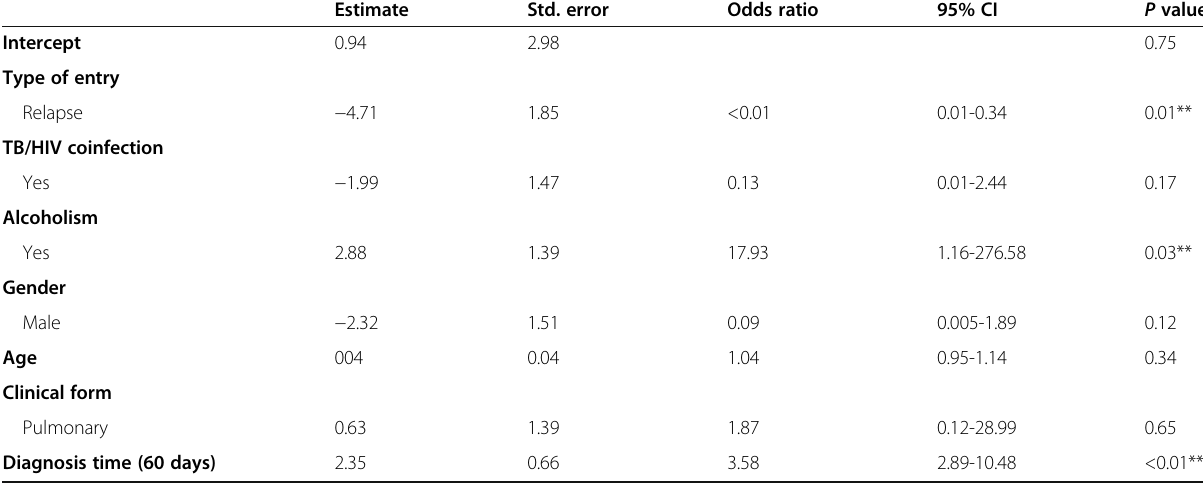
Table 5 Mixed-effect model of the associated factors with precocious deaths due tuberculosis, Curitiba-Brazil a Estimate Std.